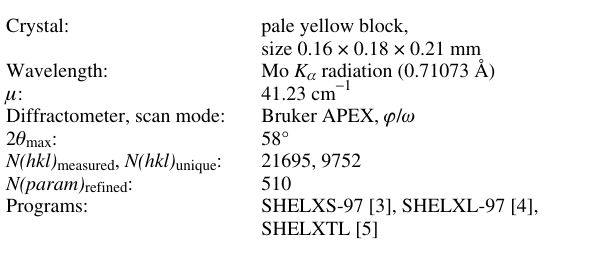
Table 1. Data collection and